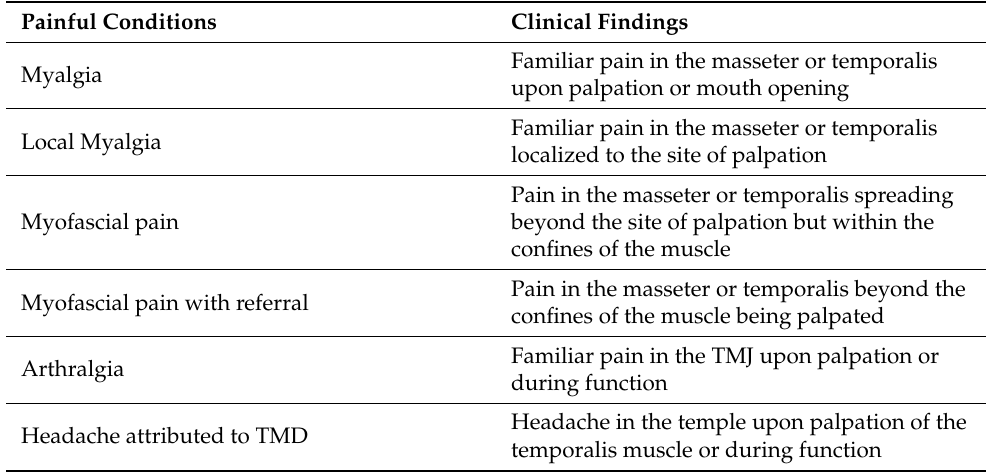
Table 1. Common diagnoses of temporomandibular disorders (TMD) and their clinical